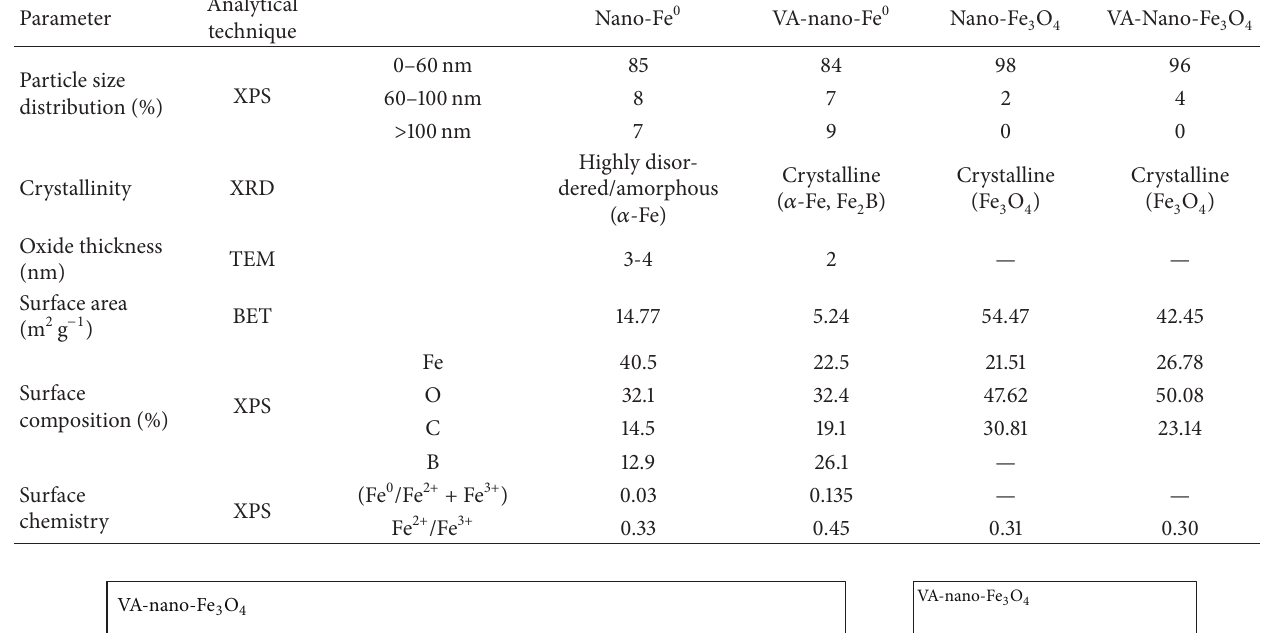
Table 1: Bulk and surface properties of the nanomaterials.